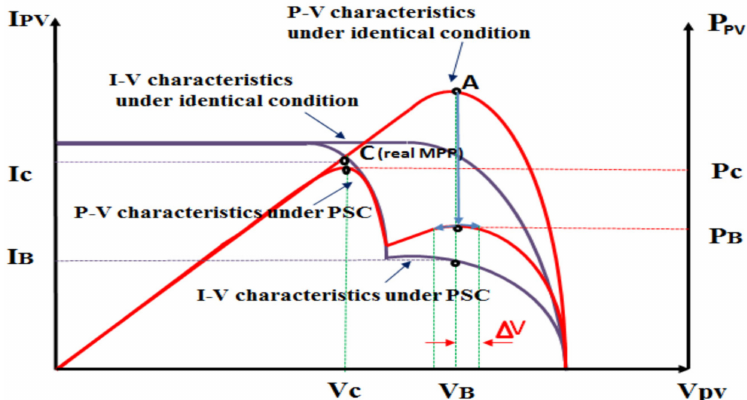
Figure 5. Conventional techniques under Partial Shaded Conditions.